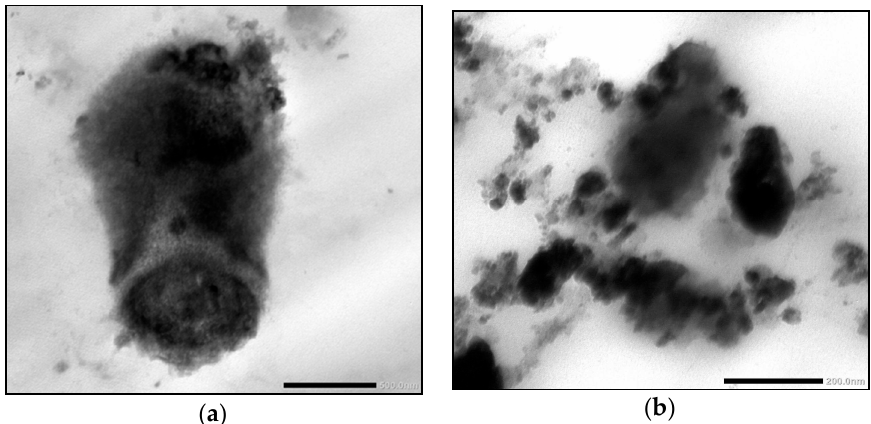
Figure 6. Transmission electron micrographs of NFHDE/AK-treated S. aureus ( a ) and C. albicans ( b ) cells.